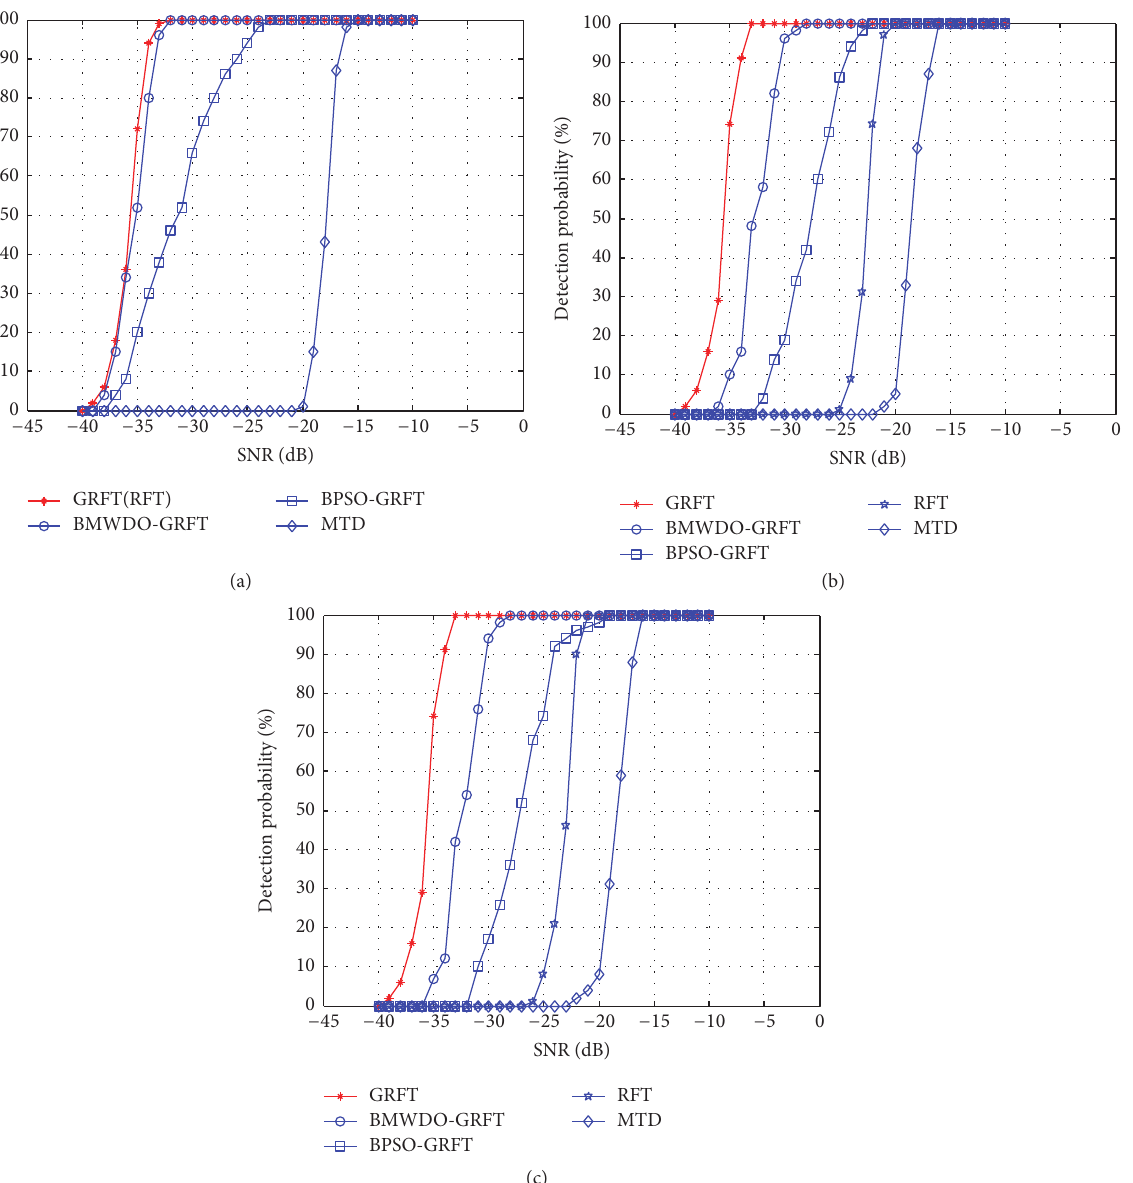
Figure 5: Detection performances of five different detectors with different motion orders. (a) Motion order is 1 ( 𝑃 = 2 ). (b) Motion order is 2 ( 𝑃 = 3 ). (c) Motion order is 3 ( 𝑃 = 4